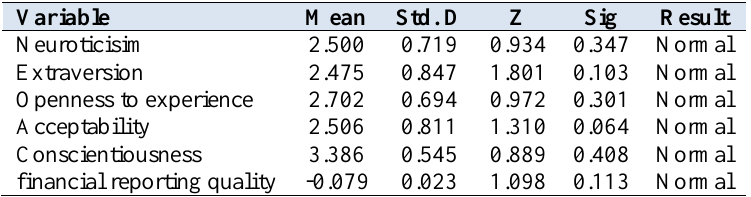
Table 2. Kolmogorov-Smirnov test output for research